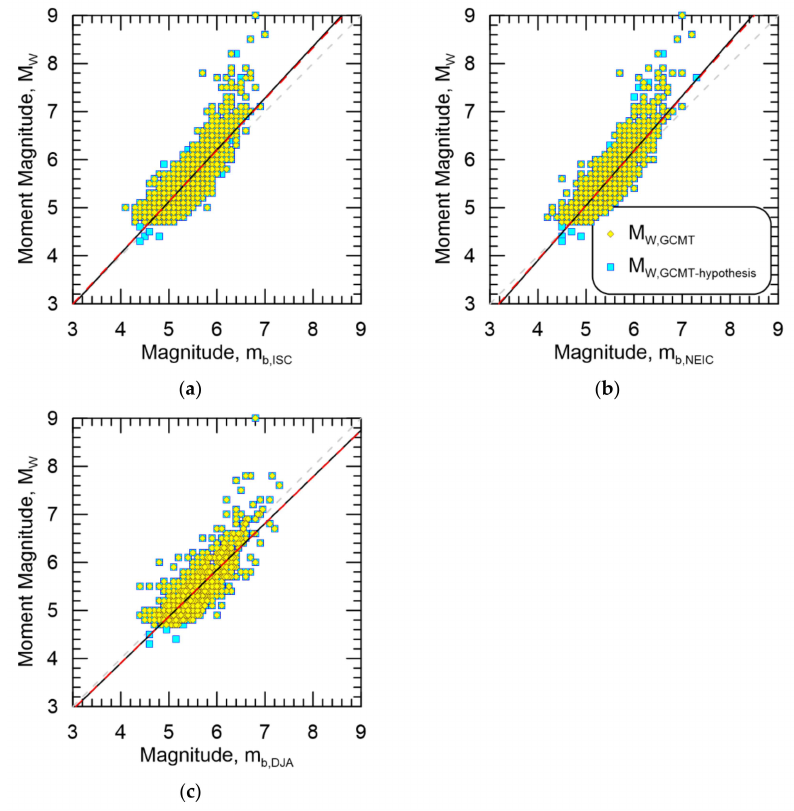
Figure 7. Resultant magnitude homogenization regressions for M W,GCMT-hypothesis against ( a ) m b,ISC , ( b ) m b,NEIC , and ( c ) m b,DJA . Data from M W,GCMT are also shown. Black line is the regression against M W,GCMT-hypothesis while the dashed red line is the regression against M W,GCMT . Table 6. Magnitude homogenization regression results from all moment magnitude pools for local magnitude types from